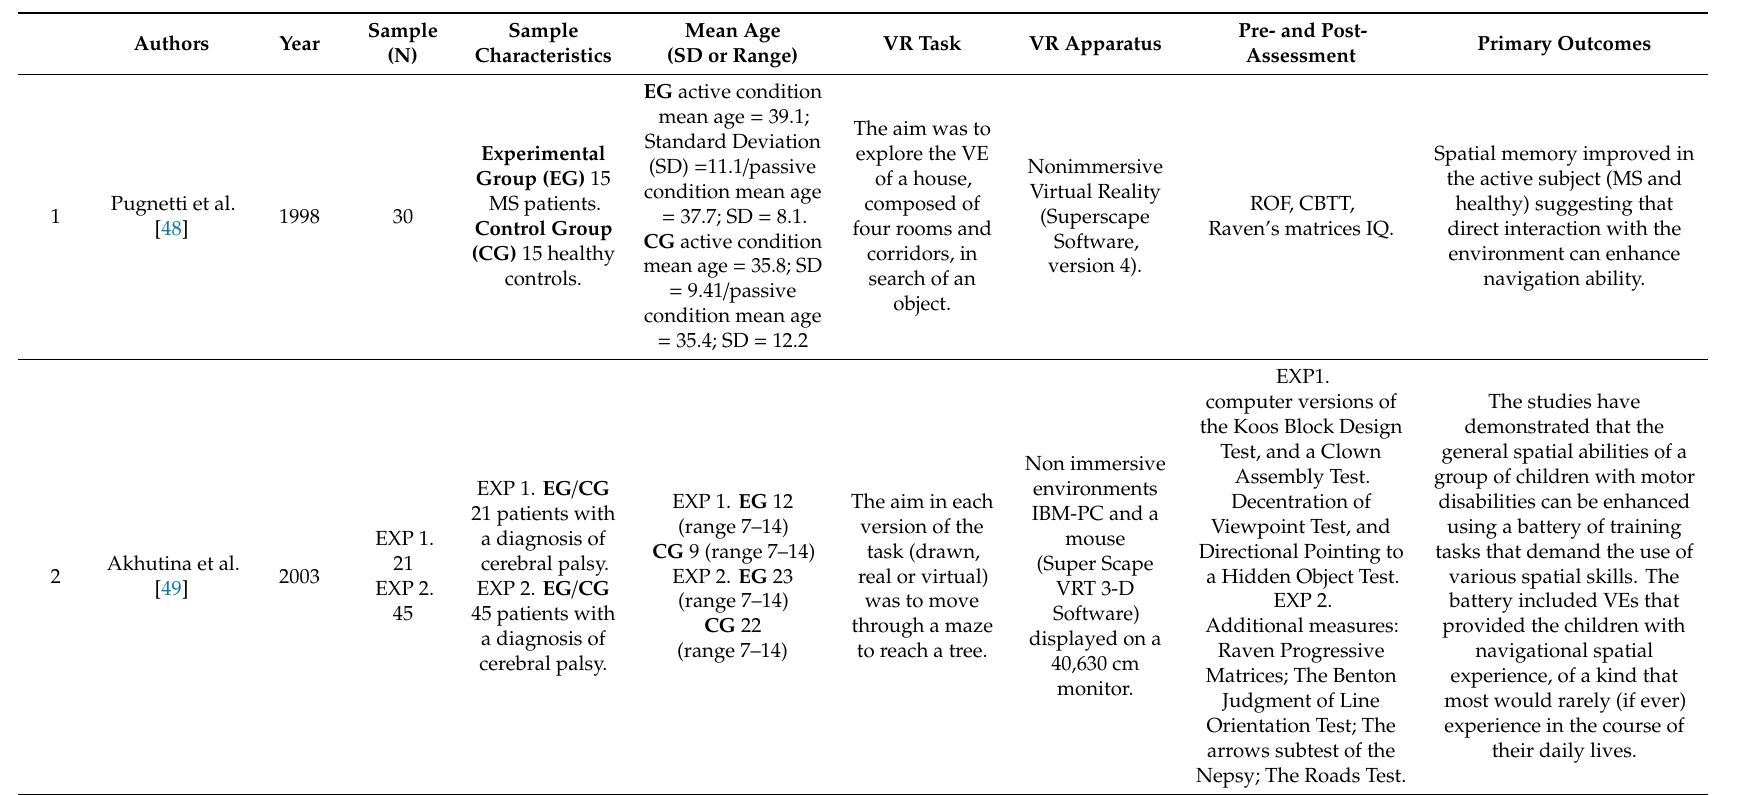
Table 1. Papers included in the PRISMA systematic review. MMSE—Mini-Mental State Assessment; MoCA—Montreal Cognitive Assessment; ACE—Addenbrooke’s Cognitive Examination; ADAS—Alzheimer’s Disease Assessment Scale; WAIS-III—Weschler Adult Intelligent Scale; RAVLT—Rey Auditory verbal